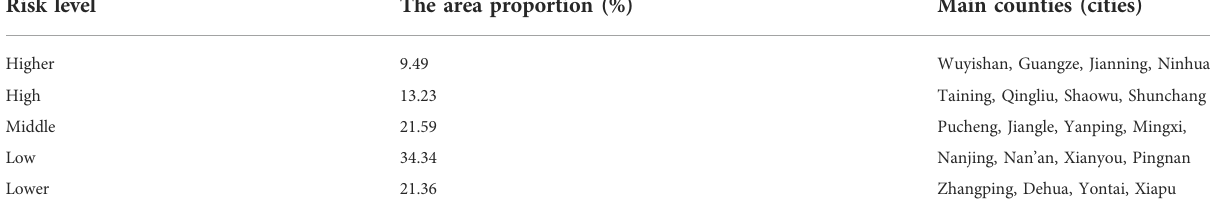
TABLE 7 Proportion of different comprehensive risk levels over the whole province.